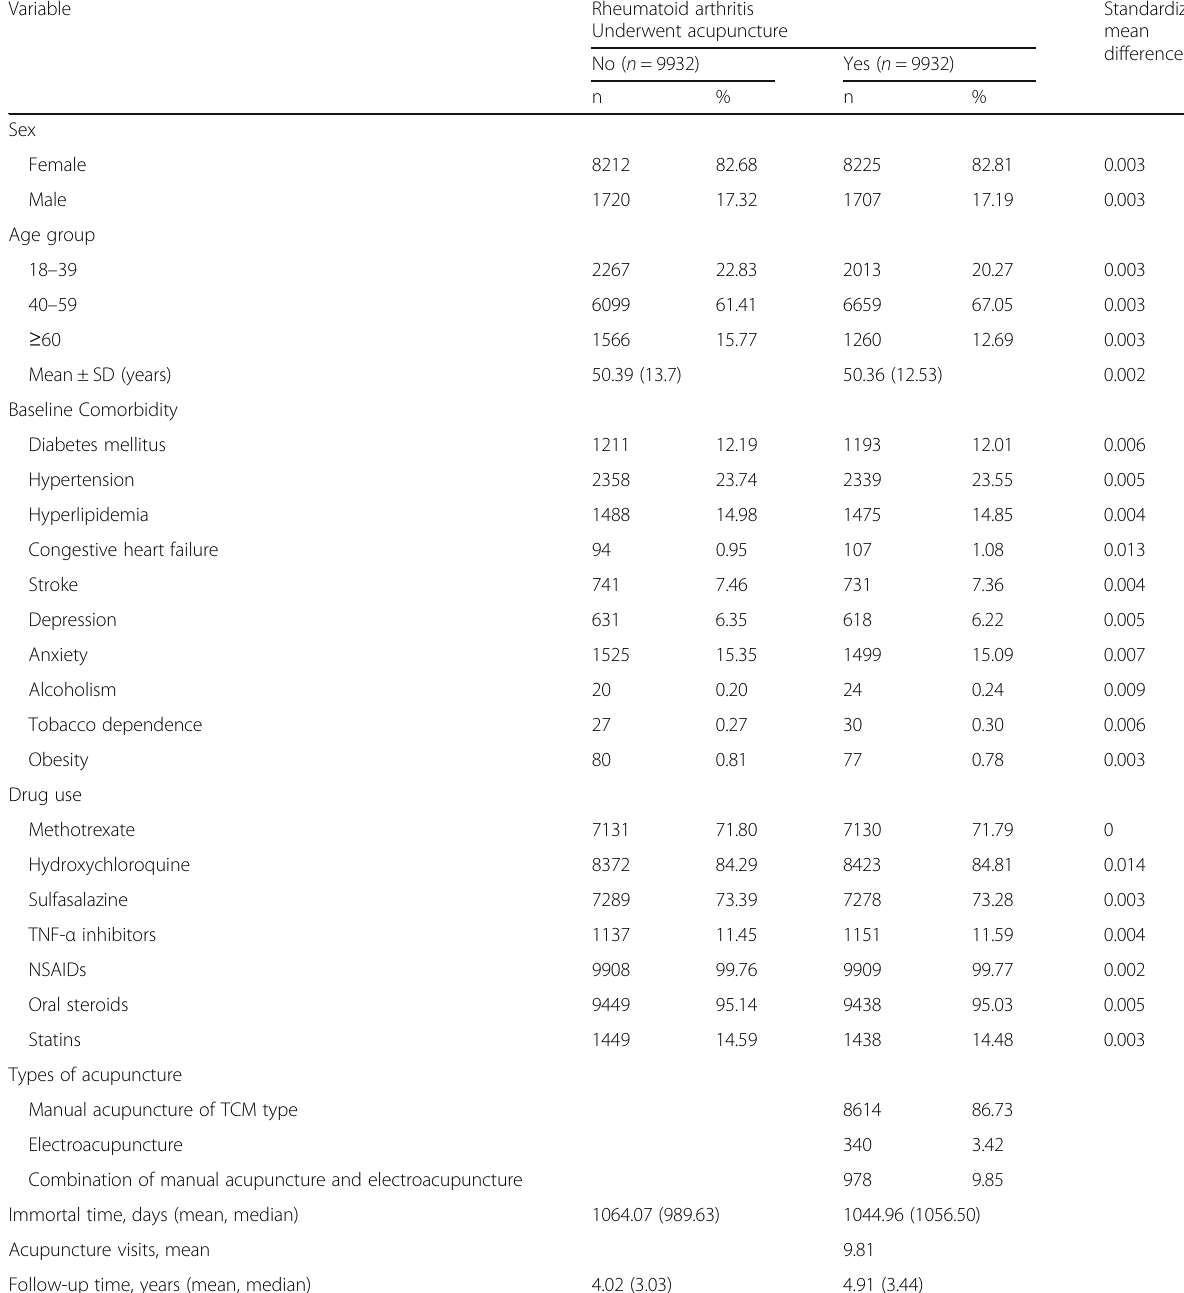
Table 1 Characteristics of rheumatoid arthritis patients according to whether they received acupuncture treatment Variable Rheumatoid arthritis Underwent